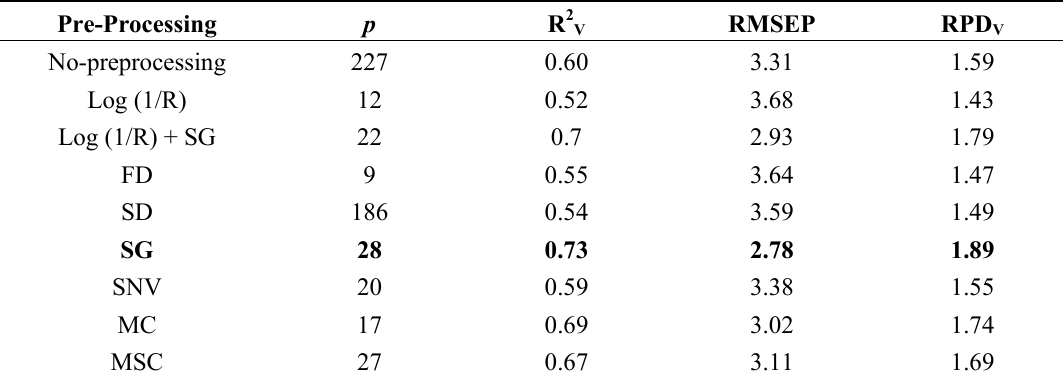
Table 4. The numbers of wavelength variables selected by the successive projections algorithm (SPA) and the performance of support vector machine regression (SVMR) combined with SPA ( i.e. , SPA-SVMR model) based on the pre-processed results with the eight methods ( i.e. , Log (1/R), Log (1/R) coupled with Savitzky-Golay (SG) smoothing (Log (1/R) + SG), first derivative with SG smoothing (FD), second derivative with SG smoothing (SD), SG, standard normal variate (SNV), mean center (MC) and multiplicative scatter correction